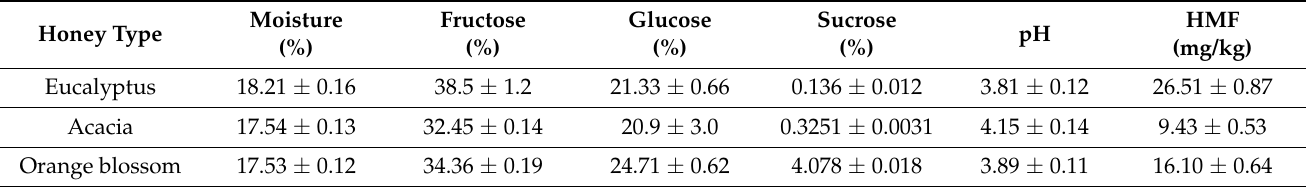
Table 1. Physicochemical parameters including standard deviation (SD) of different raw honey types. Data are based on three samples per honey type and three measurements